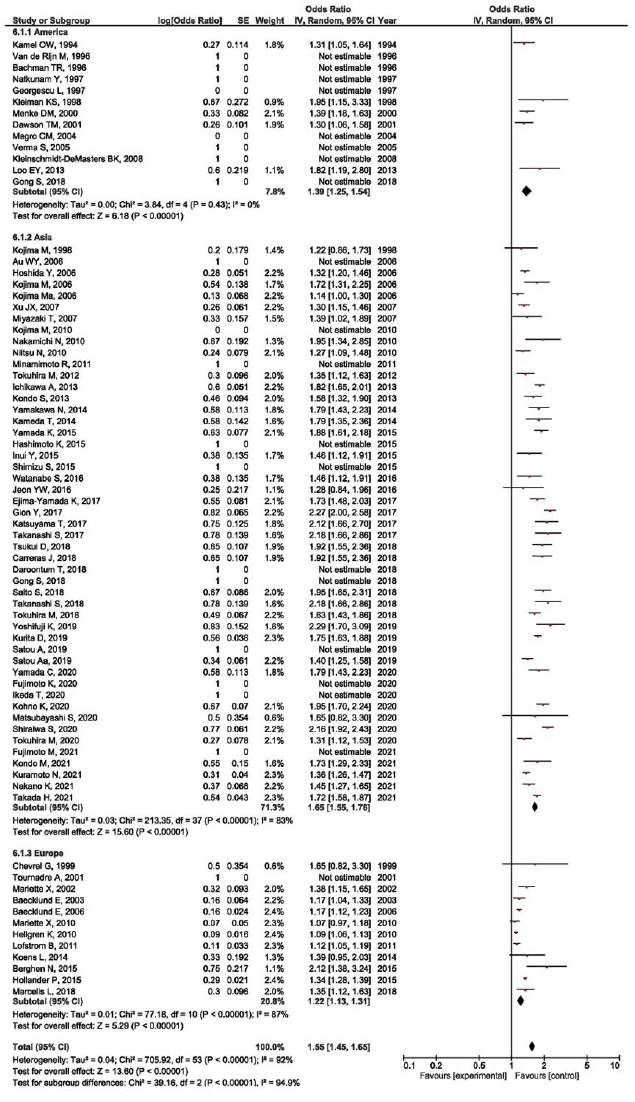
Figure 6. Meta-analysis of the prevalence of the positive EBV result in RA-LPD patients by the continent of origin (red dot represents the point estimate—prevalence and black frame represents 95%CI of the point estimate for the data from each of included studies).